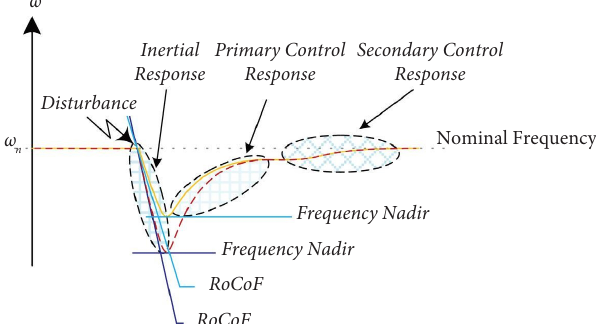
Figure 1: Frequency response to a disturbance in a conventional power system (shown by a solid yellow line) as well as a low inertial power system (shown by a dash red line), where the diferent time- scale responses such as inertial, primary control, and secondary control responses are conceptually illustrated. As shown, the yellow RoCof and frequency nadir in a conventional system are smaller than the shown RoCoF and frequency nadir in a low inertial power electronic-based power